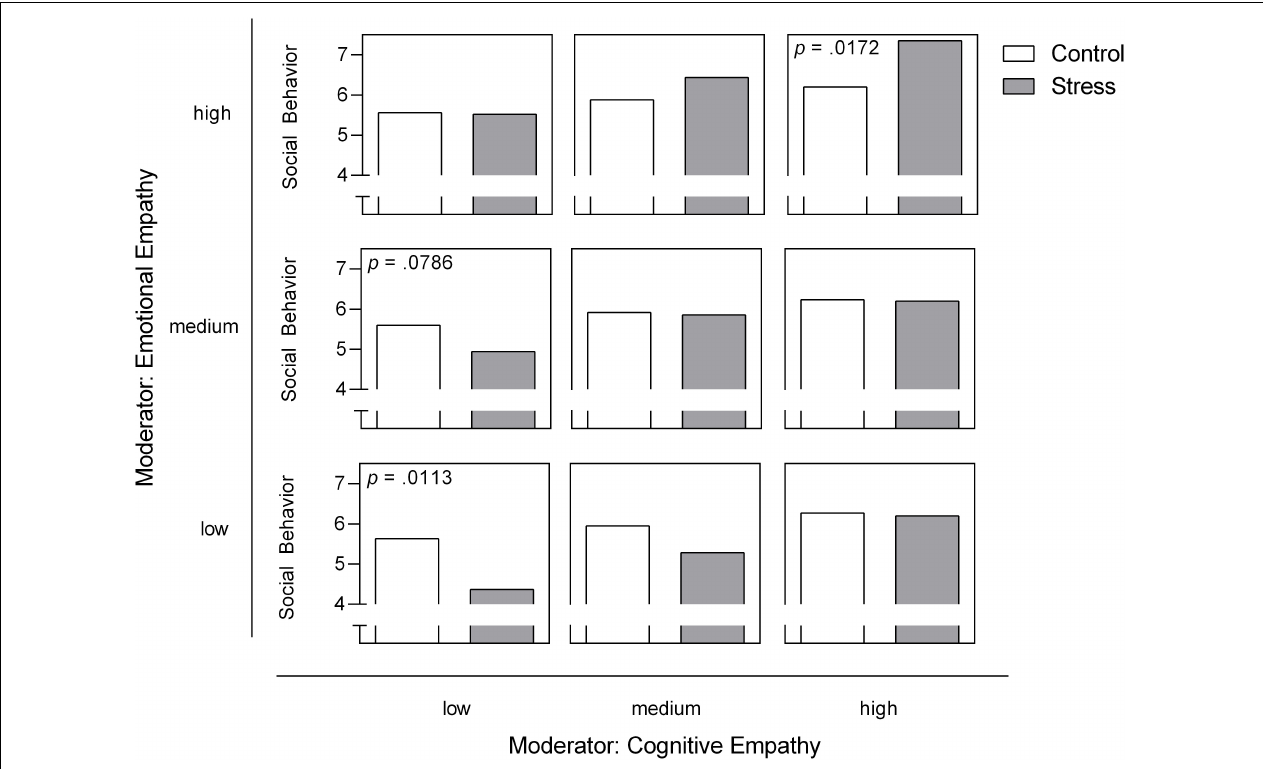
FIGURE 5 | Emotional and cognitive empathy as moderators for acute stress effects on social behavior in the post-stress conversation in participants with SAD. Low, medium and high levels represent mean ± 1 SD (48). The level of significance for the conditional effects of the focal predictor at values of the moderators is presented in case of p < 0.10 and is added to the respective